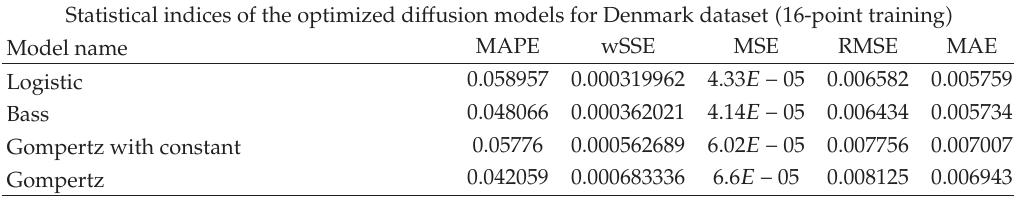
Table 20: Statistics for the optimized di ff usion models sorted by wSSE for Denmark (cid:2) forecast period—2 years (cid:3)